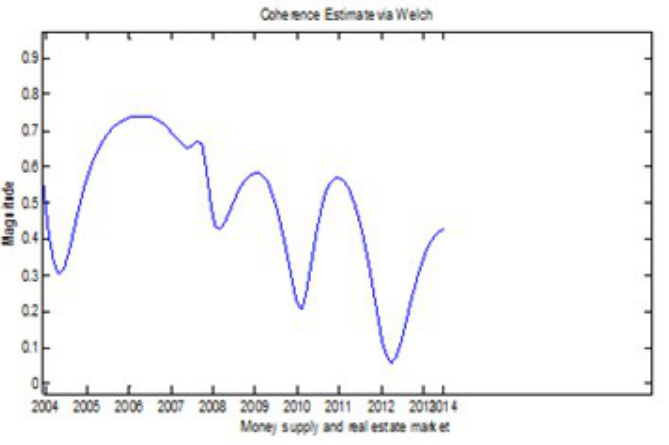
Figure 8. DCF of Money Supply and Real Estate